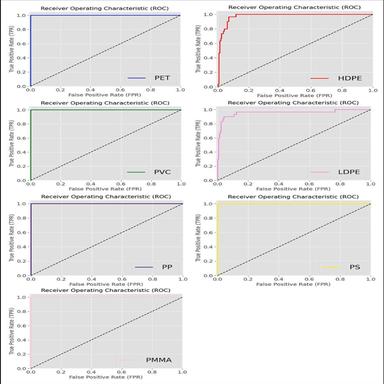
The receiver operating characteristic (ROC) curve for prediction of plastic classes based on LIBS spectra using PLS-DA model.